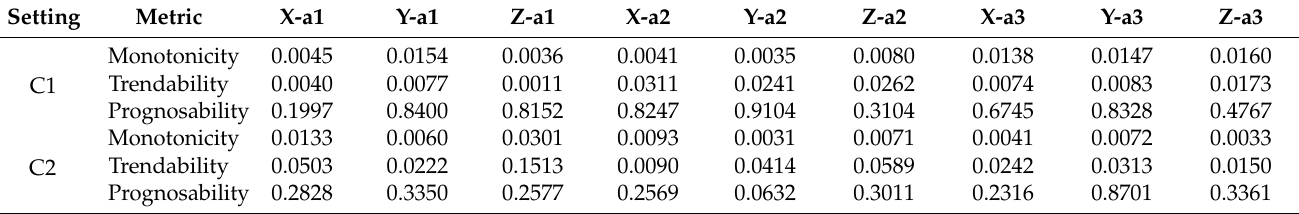
Table 13. Length of nominal and fault signals considered for the correlation coefficient